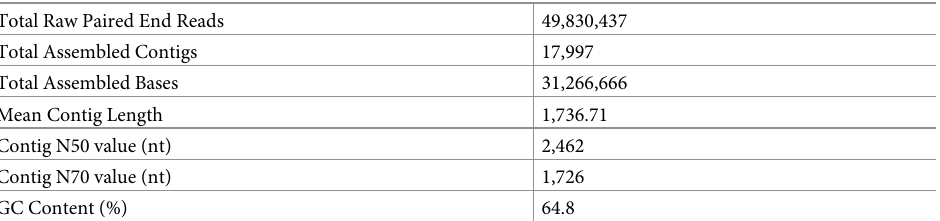
Table 1. Transcriptome summary